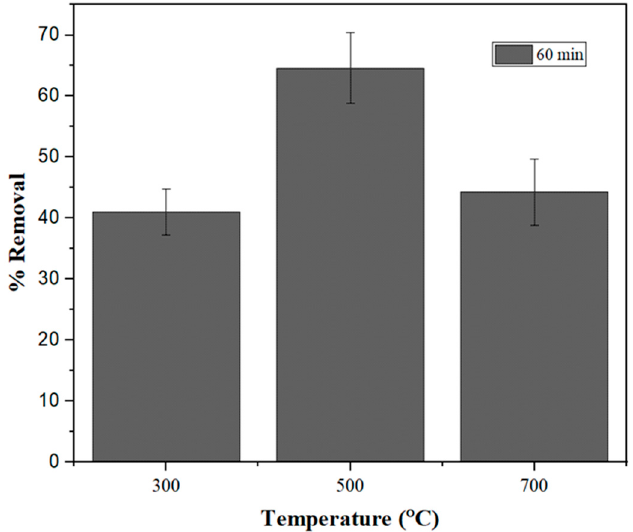
Figure 2. Removal efficiency of PSDB prepared at various temperatures (300, 500, and 700 °C) and time 60 min.